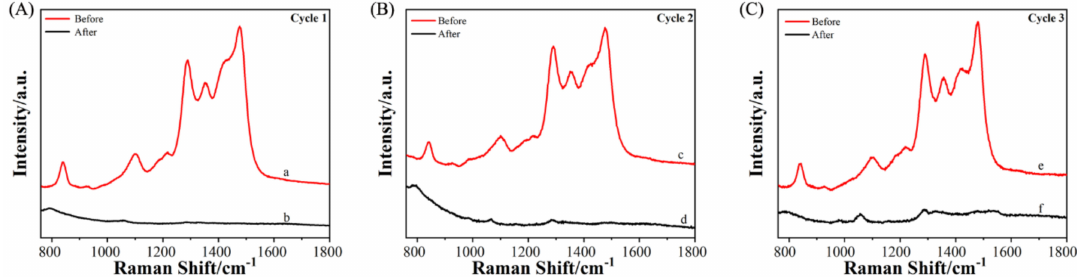
Figure 7. SERS substrate for recyclable FA detection (three cycles of FA detection). ( A ) First cycle; ( B ) second cycle; and ( C ) third cycle. The red and black spectra represent the detection of FA and the degradation after UV light irradiation,